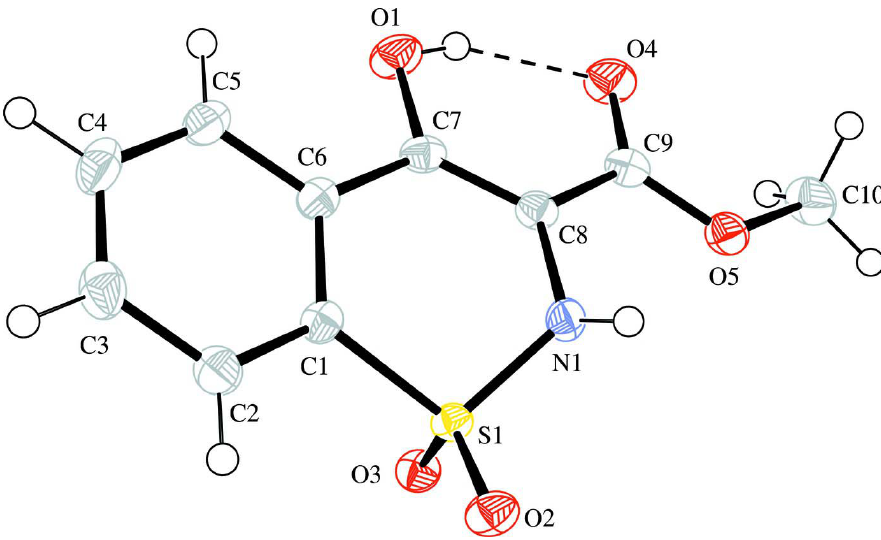
Figure 1 ORTEP - 3 (Farrugia, 1997) drawing of molecule a with displacement ellipsoids plotted at 50% probability level.